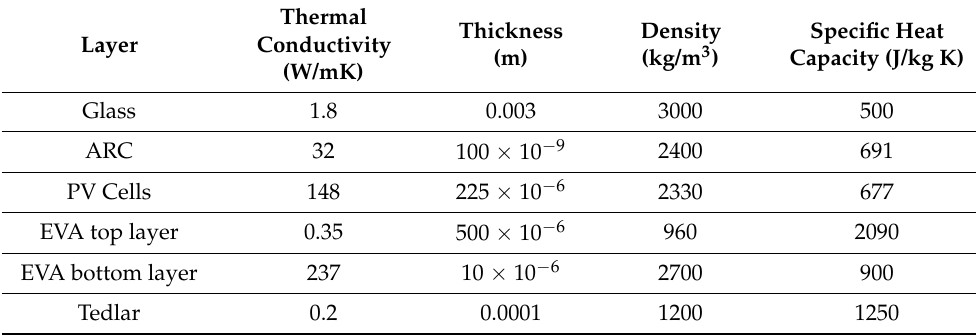
Table 1. Specifications of PV